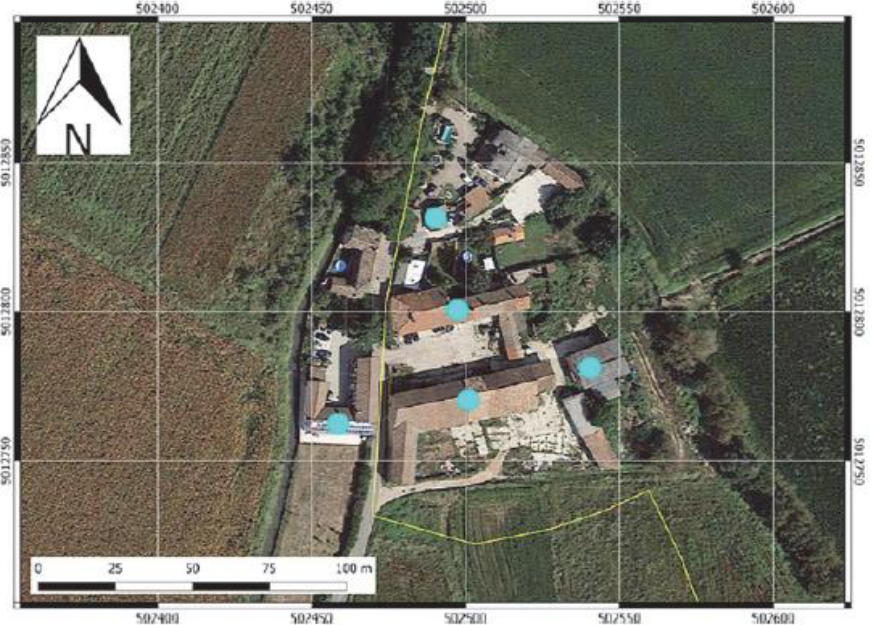
Figure 2. Identification of buildings from a reference database (overlap of Google maps (image) and OpenStreetMap (point) features): an example from Trivolzio, Pavia, Northern Italy (Franzini et al., 2020).